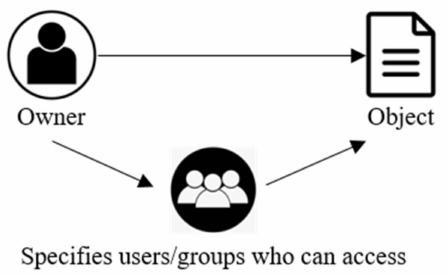
Figure 2. Implementation of the DAC model.